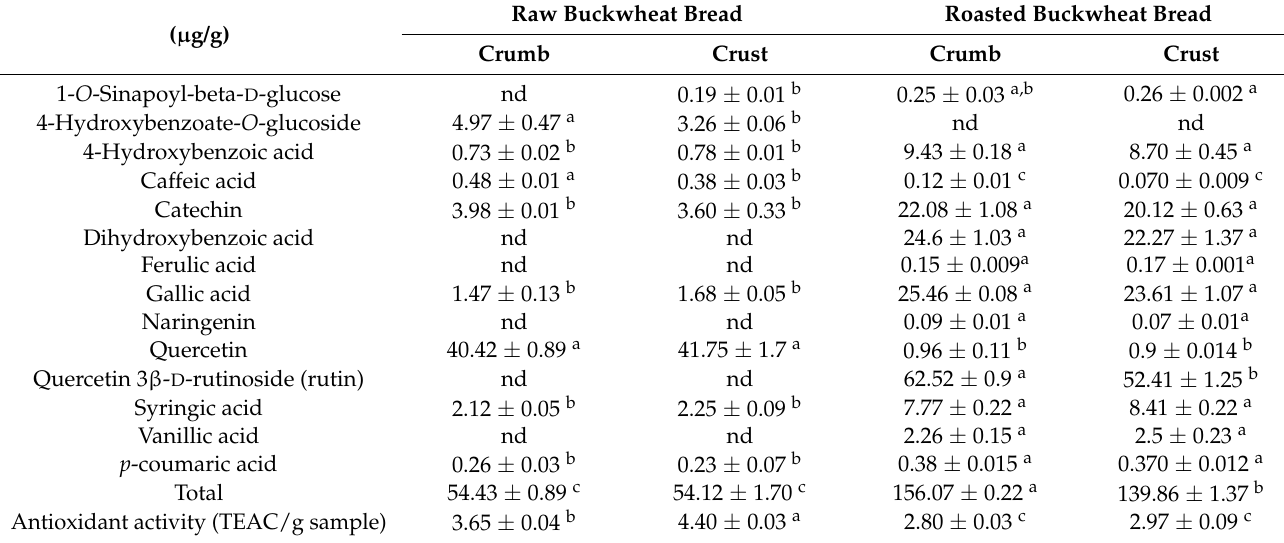
Table 1. Phenolic compounds and antioxidant activity of raw and roasted buckwheat